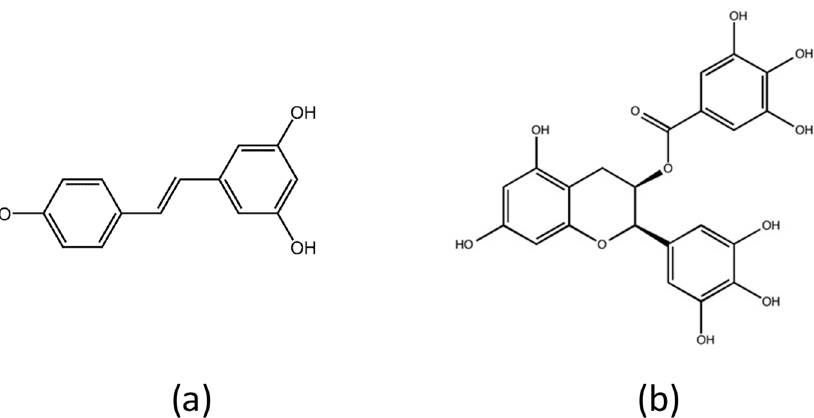
Figure 3. Chemical structures of polyphenols used in this study. ( a ) Resveratrol (C 14 H 12 O 3 ) is found in red wine and red grapes. ( b ) Epigallocatechin-3-gallate (C 22 H 18 O 11 ) is found in green tea.